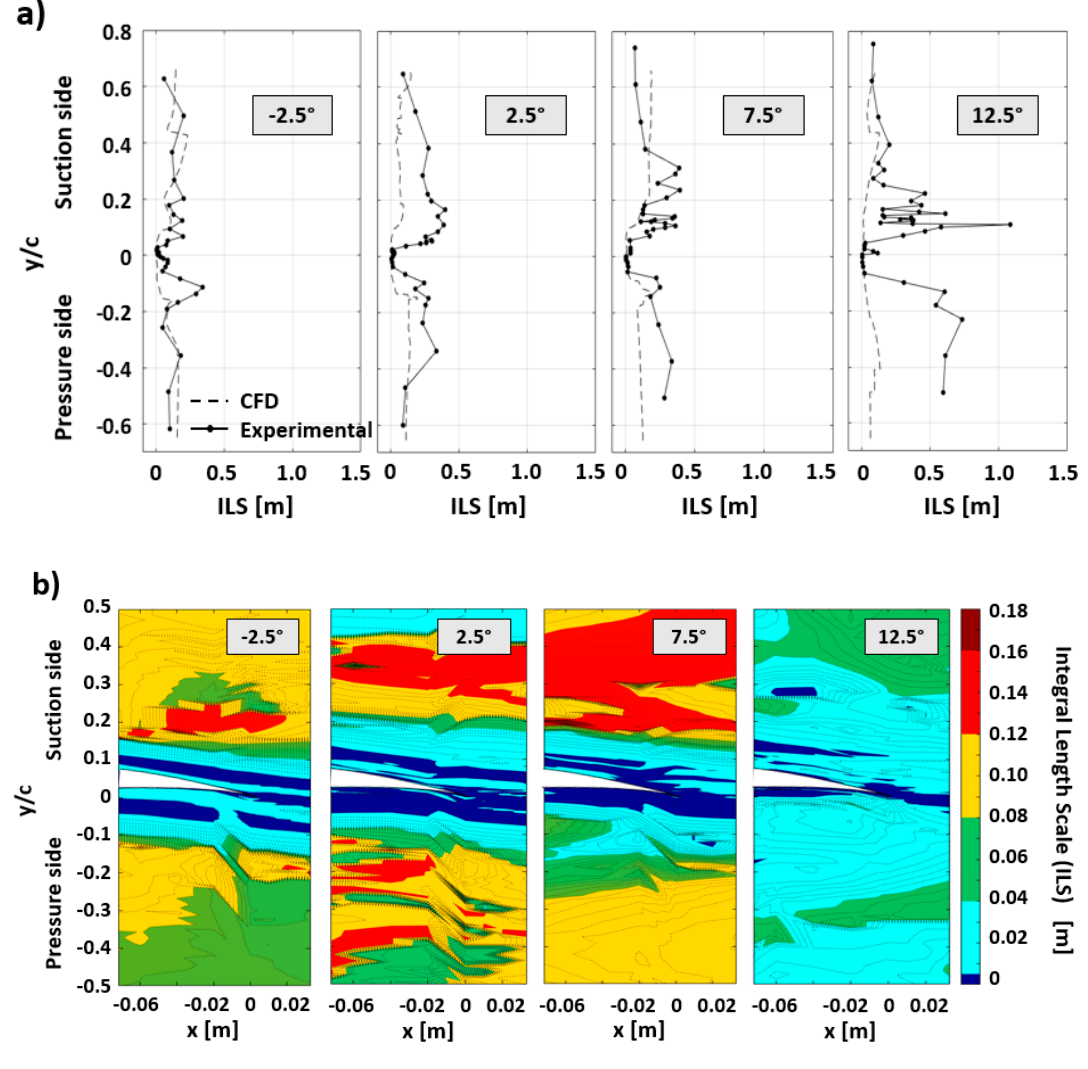
Figure 9. ( a ) Transversal distributions of integral length scale, comparing numerical and experimental results for all the angles of attack tested. ( b ) Numerical contour maps showing the typical distributions around the airfoil trailing edge.